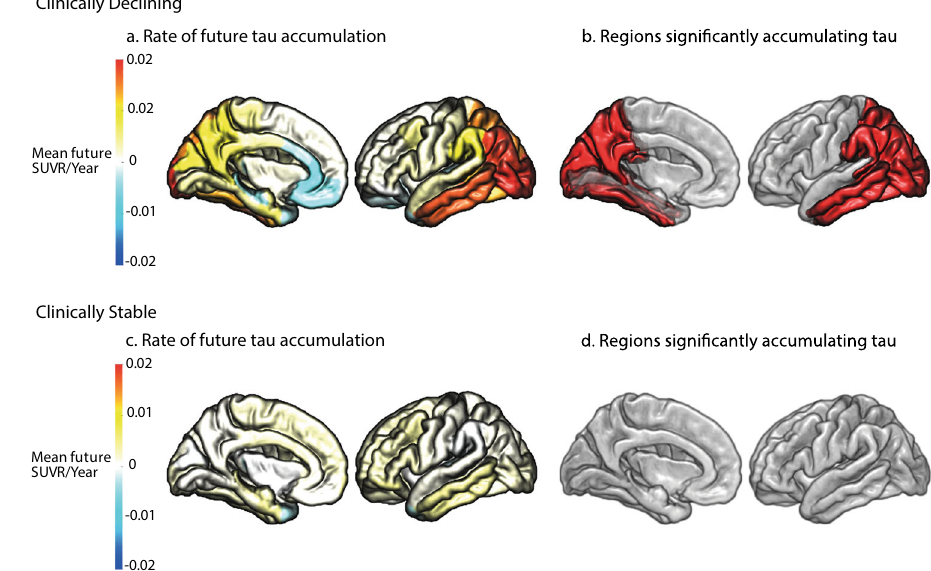
Fig. 4 Regional future rate of tau accumulation. Future annualised rate of tau accumulation for ADNI3 individuals across the 36 Desikan – Killiany ROIs. a Mean future annualised rate of tau accumulation for individuals classi fi ed as Clinically Declining. b The regions in red are signi fi cantly accumulating tau for individuals classi fi ed as Clinically Declining (one-sided t-test (right) against 0, p < 0.05 uncorrected). c Mean future annualised rate of tau accumulation for individuals classi fi ed as Clinically Stable. d The regions in red are signi fi cantly accumulating tau for individuals classi fi ed as Clinically Stable (one-sided t -test (right) against 0, p < 0.05 uncorrected). Source data are provided as a Source Data fi